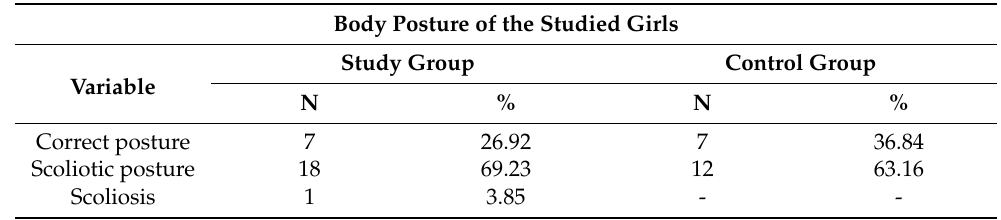
Table 2. Cross-tabulation for body posture in the frontal plane divided into correct posture, scoliotic pos-ture and scoliosis in the study and control